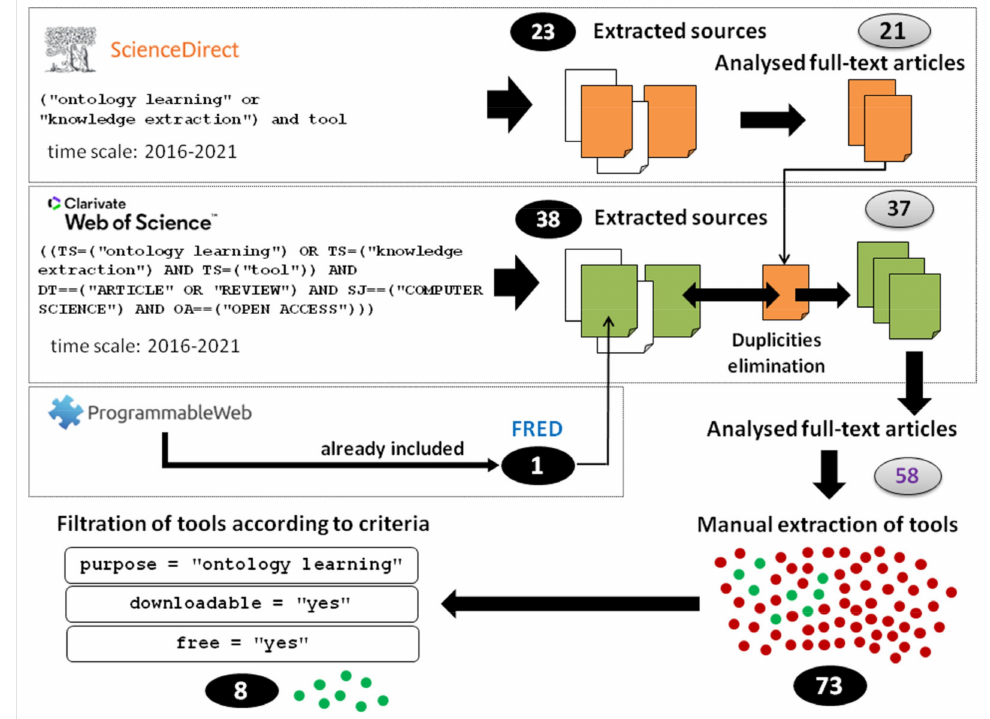
Figure 2. Illustration of the articles and tools selection